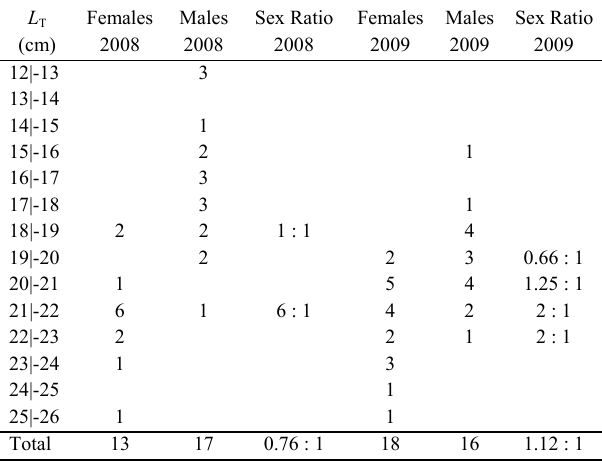
Table 5. Number of females and males sampled and sex ratio (female : male) by size for A. afer during reproductive period in 2008 and 2009.